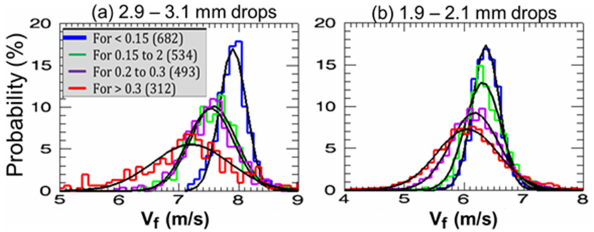
Figure 6. Histograms of 3 and 2mm fall velocities for various in- tervals of u (cid:48) /V t from the six events. Their fitted Gaussian curves (in black) are superimposed.